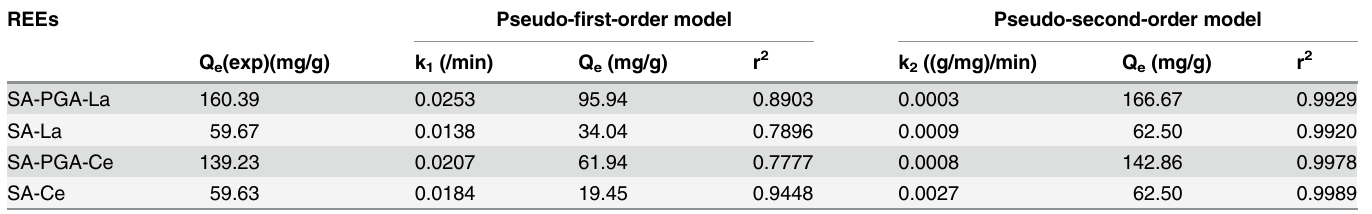
Table 2. Pseudo-first-order and pseudo-second-order kinetic parameters for the adsorption of REE ions. (C 0 : 220 mg/L). REEs Pseudo- fi rst-order